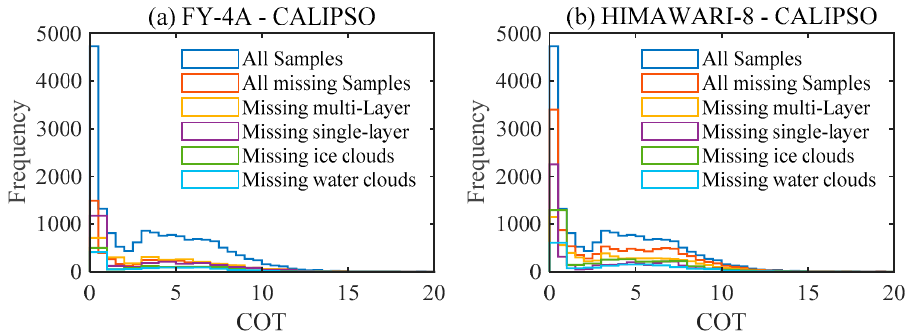
Figure 7. The frequency distribution of missing data of FY-4A and HIMAWARI-8 varies with COT. ( a ) FY-4A and ( b ) HIMAWARI-8.